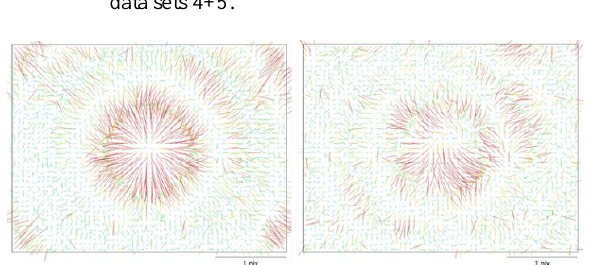
Figure 4. Resulting correlations of different interior orientation parameters for Canon D200 of combined processed data sets 4+5.